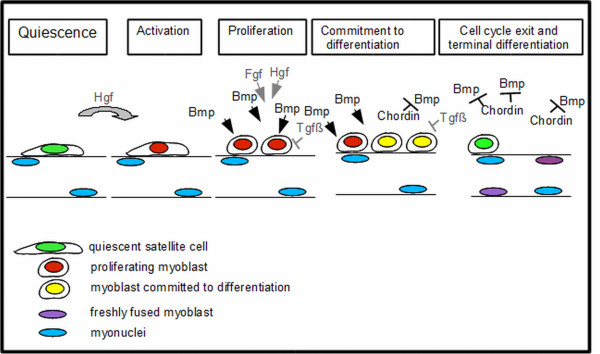
Function of BMP signaling during satellite cell differentiation. Quiescent satellite cells (green) do not respond to BMP signals. Upon activation, satellite cells express MyoD and respond to BMP signals with phosphorylation of p-Smad (red) and reduced differentiation. After satellite cell descendents are committed to differentiate (yellow) they express Myogenin and subsequently the BMP inhibitor Chordin. Upon inhibition of BMP signaling, myoblasts exit the cell cycle, fuse into myotubes and undergo terminal differentiation (purple). Postmitotic myonuclei (blue) irreversibly loose the competence to respond to BMP signals.